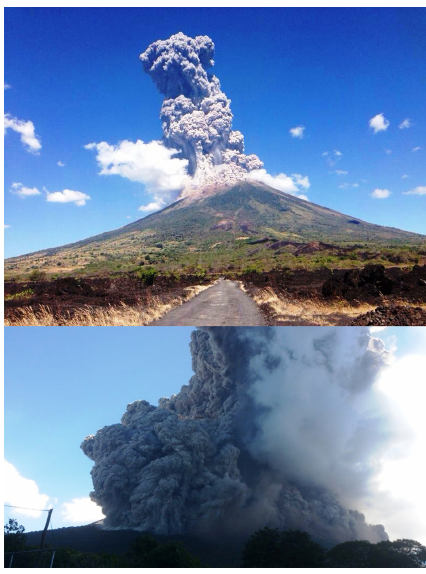
Figure 4. Images of the 29 December 2013